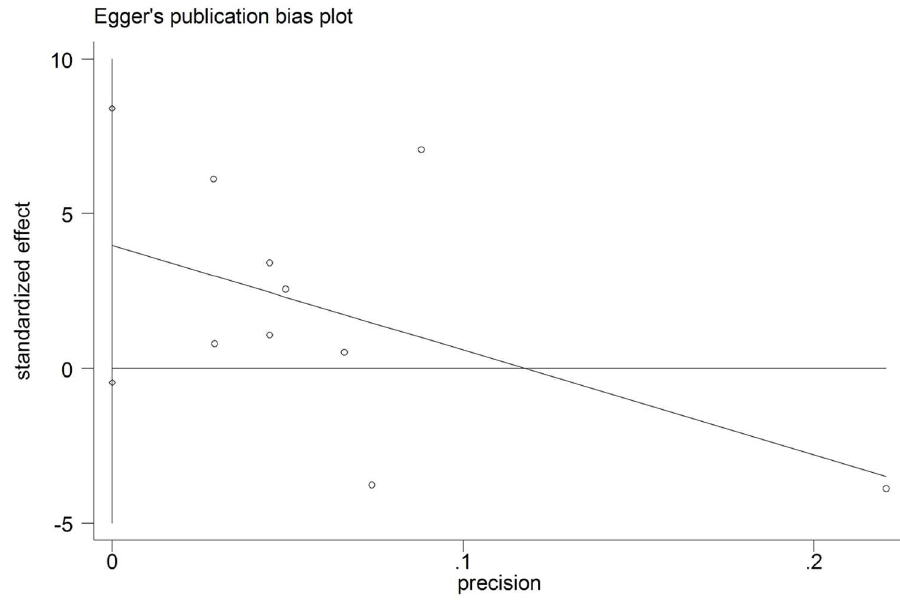
Fig 6. Egger test results of studies on operation time.